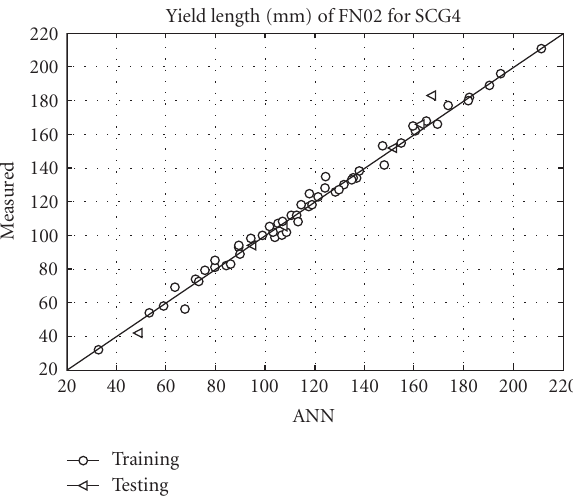
Figure 18: Comparison of the measured and predicted yield length based on temperature and pressure for 316L.